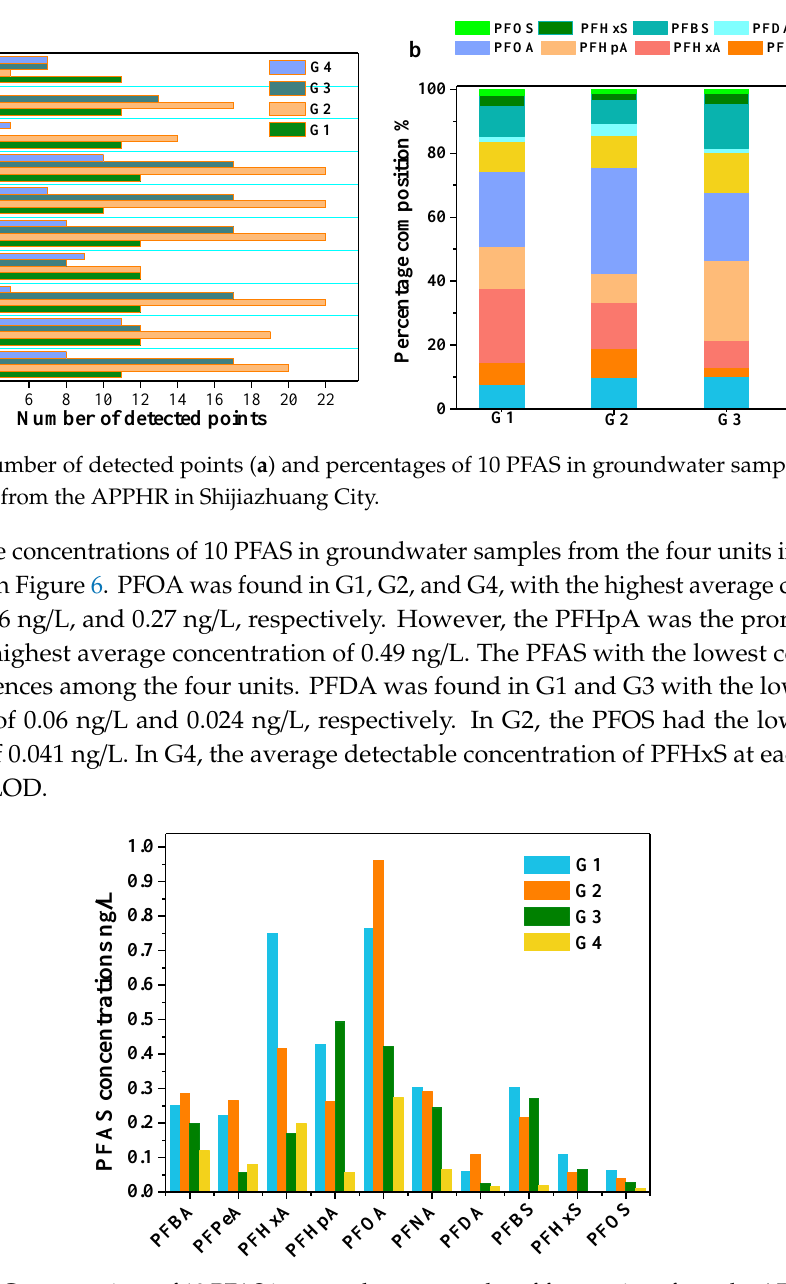
Figure 6. Concentrations of 10 PFAS in groundwater samples of four regions from the APPHR.